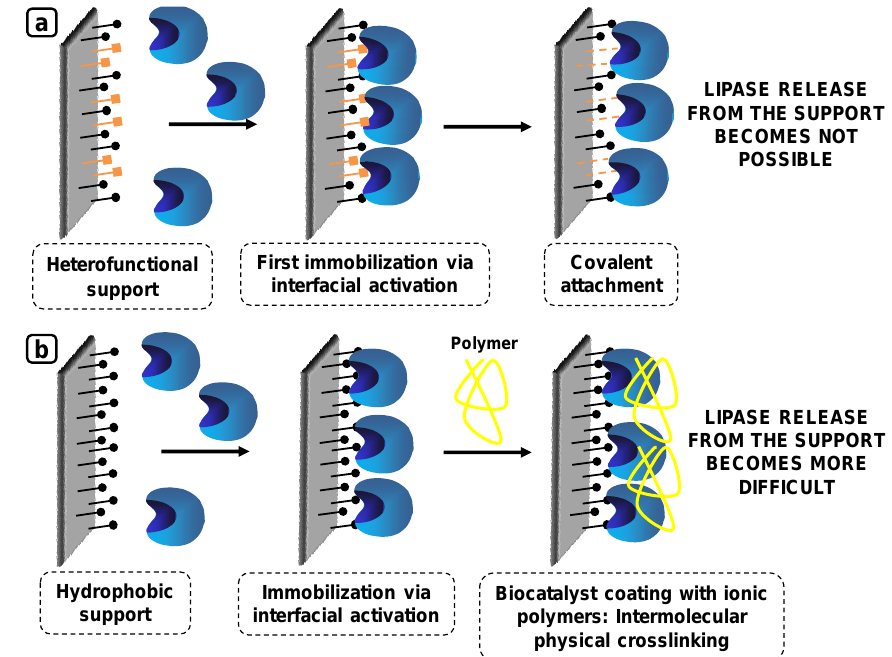
Figure 20. Preventing the risk of lipase release when immobilized on hydrophobic supports by ( a ) use of heterofunctional acyl-reactive groups supports or ( b ) physical intermolecular crosslinking with ionic polymers.